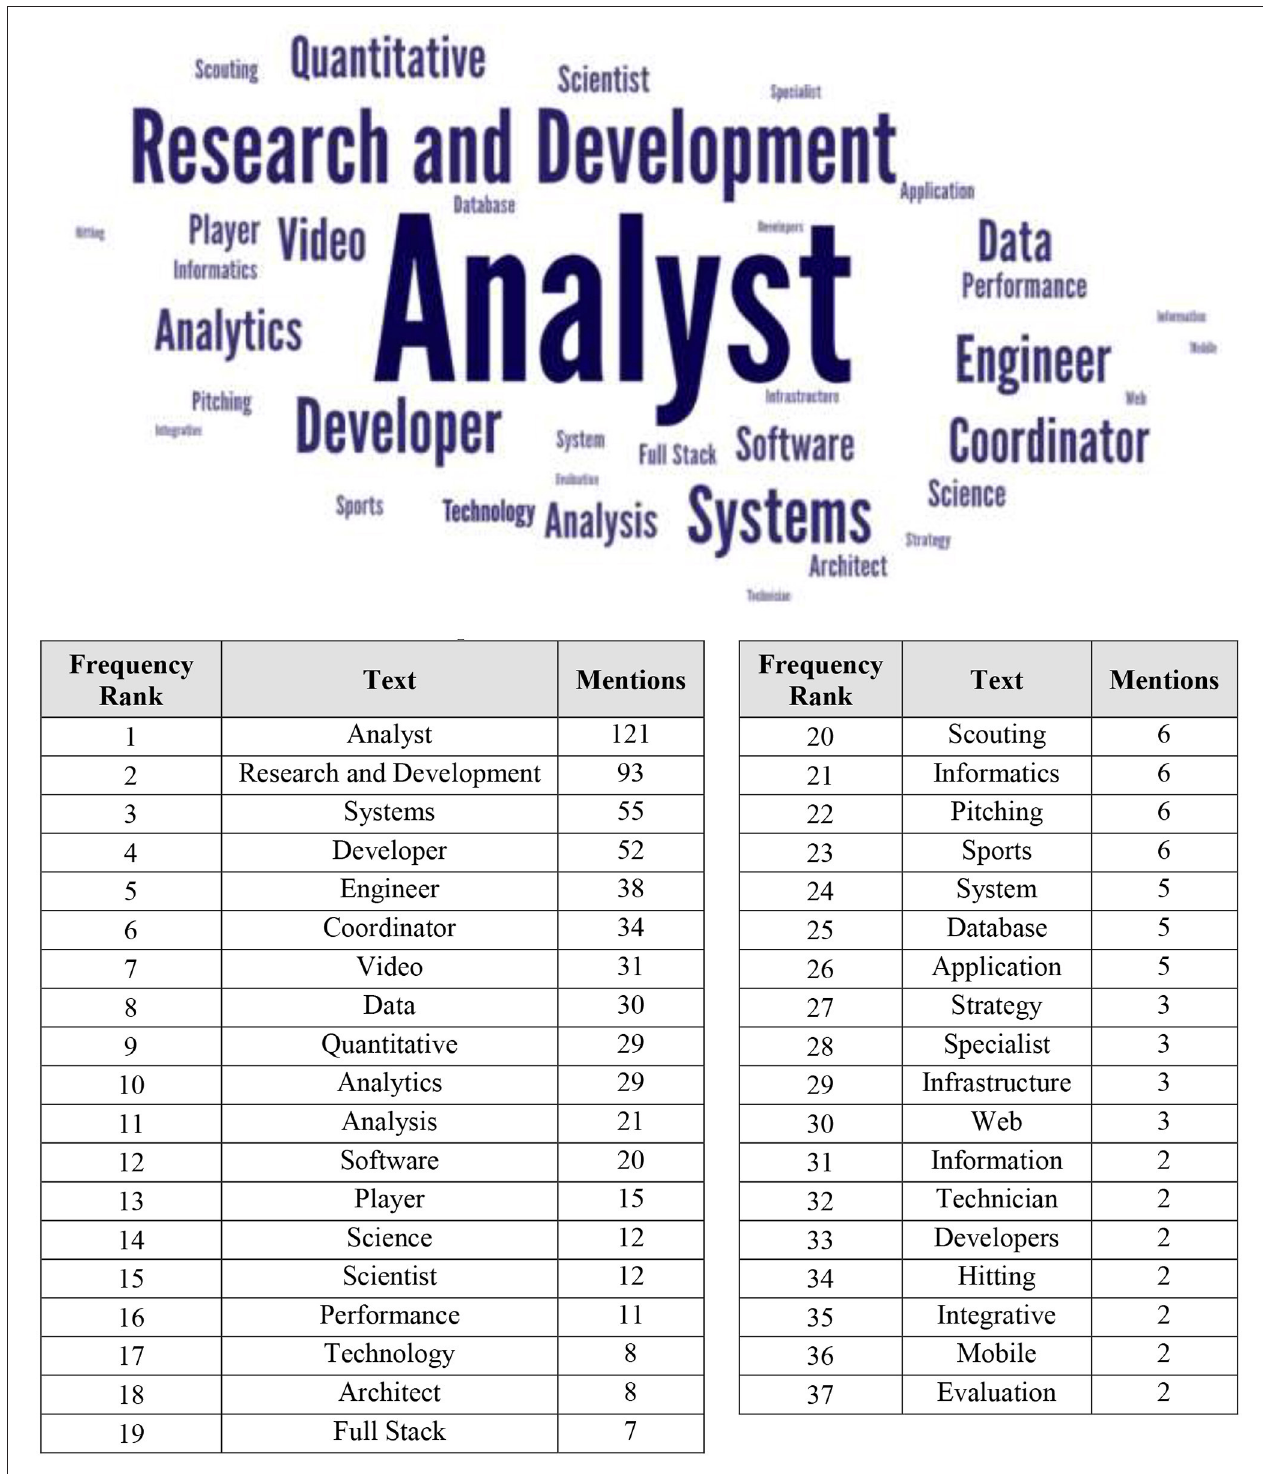
FIGURE 8 | MLB club player-side analytics groups: word cloud of position descriptors from the 2020 media guides of all 30 MLB clubs.